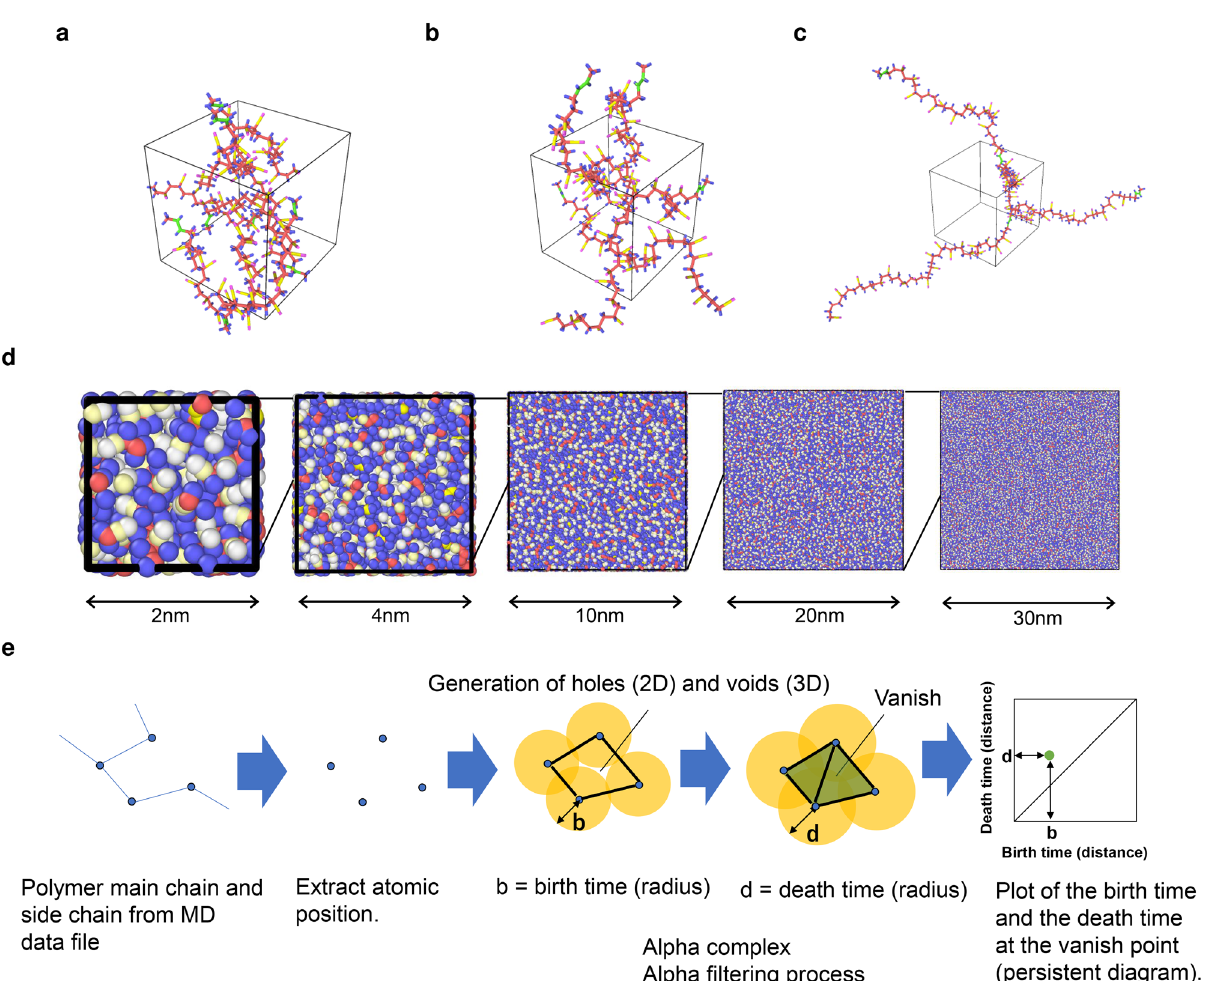
Figure 1. Polymer image for the simulation cell size of 2 nm in sample 1 and Conceptual diagram of persistent homology. These all atom coordinates are used for the persitent diagram computation. (a) 10mer of polymer chain length. The polymer does not stick out of the cubic cell. (b) 20 mer of polymer chain length. The polymer sticks out of the cubic cell. (c) 40 mer of polymer chain length. The polymer significantly sticks out of the cubic cell. (d) The difference in the higher-order structure change for each simulation cell size (2 nm to 30 nm) of sample 1 with different colors as different atoms in the equilibrium condition. There are abstract changes but not directly mentioned. (e) Method to obtain a persistent diagram (PD) using alpha comlex of each atom of a polymer from a data file of MD data. It is shown that the birth time becomes longer as the plot of the PD goes to the upper right, and it has a large structure. The farther the plot is from the diagonal line, the greater the difference between the birth time and death time, indicating a stable structure that does not easily